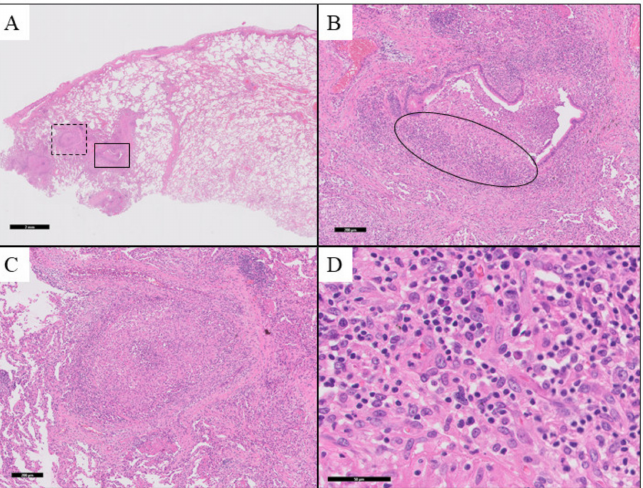
Figure 2. Pathological findings of the surgical lung biopsy. ( A ) Membranous to respiratory bronchi- oles (hematoxylin and eosin (H&E) stain; magnification, × 5). ( B ) The lower right enclosed area of Panel ( A ). The airway becomes erosive, and histiocytes enter the airway and form granules. Inflam- matory cell infiltration, mainly by lymphocytes and plasma cells, was observed around the erosions (H&E stain; magnification, × 50). ( C ) The upper left enclosed area of Panel ( A ). Granulomas are seen around the ruptured bronchus. There is little necrosis inside, but neutrophil infiltrates. ( D ) Enclosed area in ( B ). The inflammatory cells that infiltrate the airway near the erosions are lymphocytes and plasma cells.